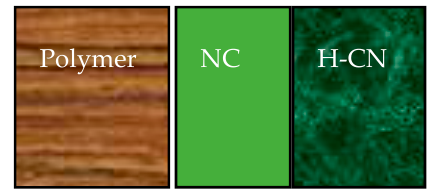
Figure 7. Polymer coated with neat NC and hydrophobic NC (H-NC).